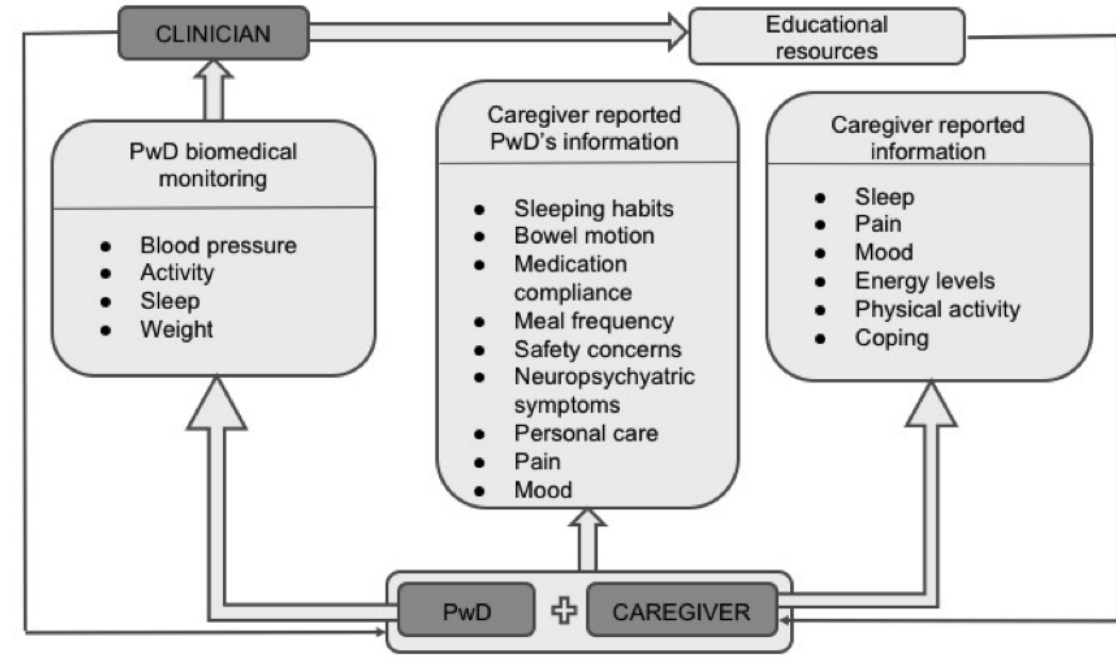
Figure 1. Representation of the Connected Health platform